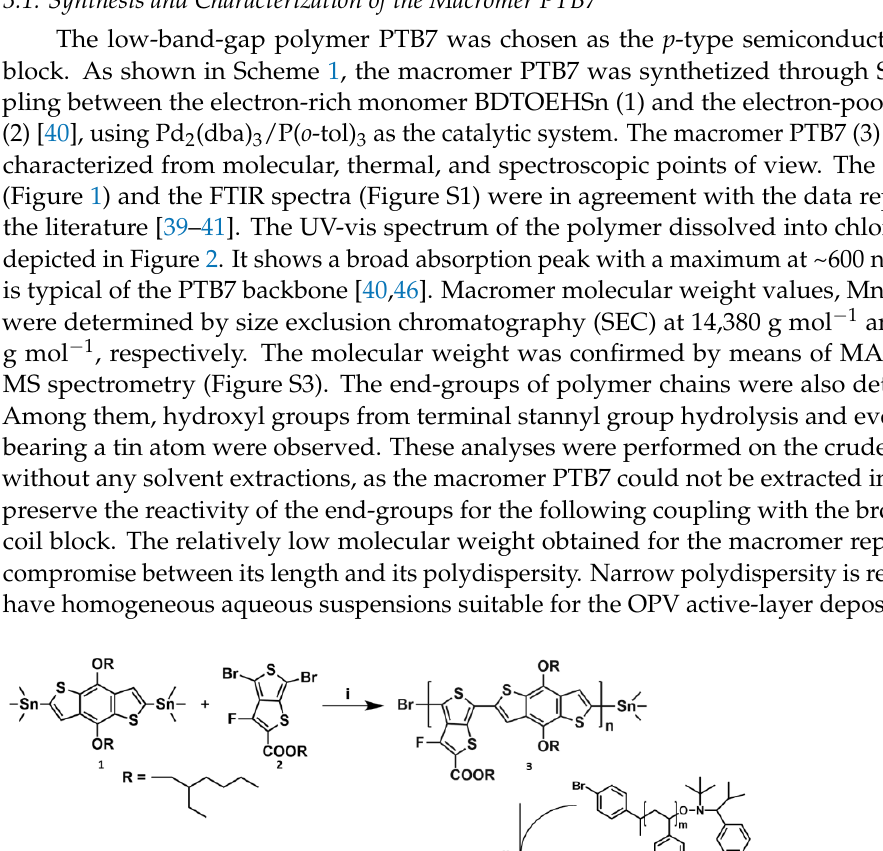
Figure 2. Comparison between the spectra of homemade PTB7 (blue) and of PTB7 ‐ b ‐ P4VP (red) dissolved into chloroform. 3.2. Synthesis and Characterization of the Rod–Coil Block Copolymer PTB7 ‐ b ‐ P4VP PTB7 ‐ b ‐ P4VP was synthetized using step ‐ growth ‐ like polymerization method. We prepared and characterized the two properly functionalized polymeric backbones, PTB7 and P4VP, for the following coupling [33,48]. The hydrophilic segment P4VP was tailored with around 15 repeating units on the basis of the relationship between the molecular structure and the NP ‐ OPV devices efficiency found for the PCPDTBT ‐ based rod ‐ coil BCPs with P4VP segments of increasing length [28]. Furthermore, we kept in mind that longer alkyl chain surfactants improve the charge mobility in OFET based on NPs [49]. In addition to this structural consideration, the design of PTB7 ‐ b ‐ P4VP took into account the process feasibility, in order to obtain a shorter coil, and a chain ‐ growth ‐ like approach was needed with a considerable increase in the synthetic complexity of the material [33]. The coil presence avoids the use of surfactants as it interacts with the aqueous medium and stabilizes the aqueous ‐ non ‐ aqueous interfaces which ensure colloidal stability of WPNP dispersions [30]. The segment of P4VP (4) was achieved through nitroxide ‐ mediated radical polymerization (NMRP) using the radical TIPNO as a mediator, as reported in the literature [50]. The coil length was confirmed by 1 H ‐ NMR analysis and the calculated repeating unit number was considered as an average value. The two blocks were linked together through Stille coupling, as shown in Scheme 1. The purification to remove the unreacted P4VP was performed through repeated precipitations into methanol (coil ‐